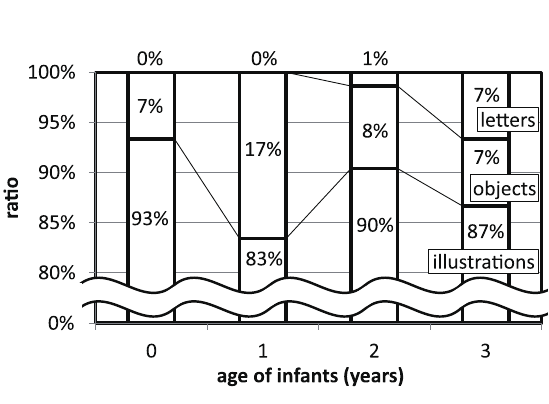
Fig. 4. Frequencies of Pointing